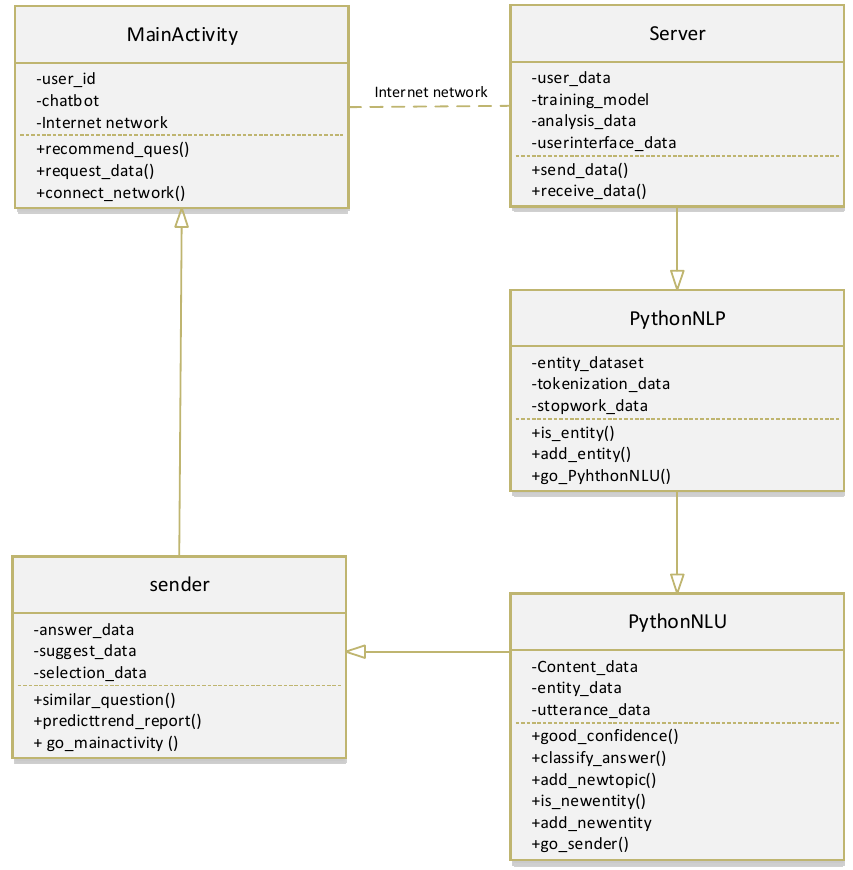
Figure 10. UML framework of the Operational Solution Assistant system.